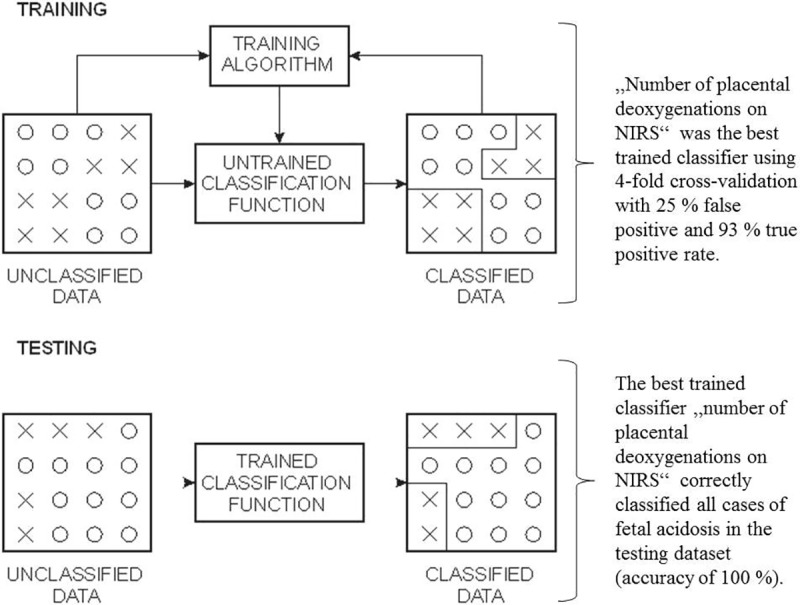
Schematic illustration of computer-based statistical classification used for evaluation of predictive values of CTG and NIRS for neonatal acidosis.